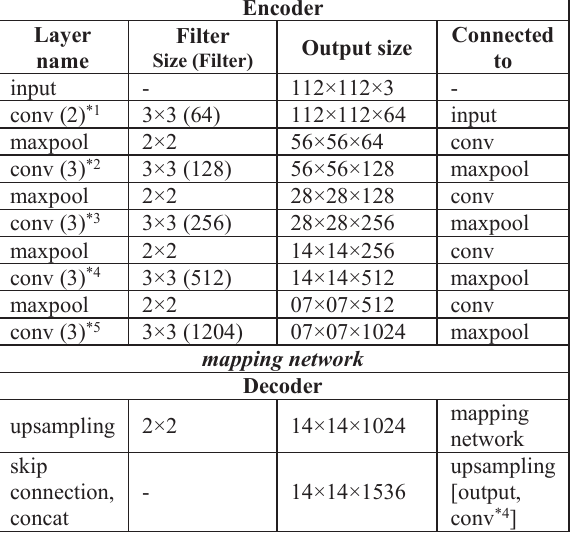
Table 1. Autoencoder layer configuration used in proposed